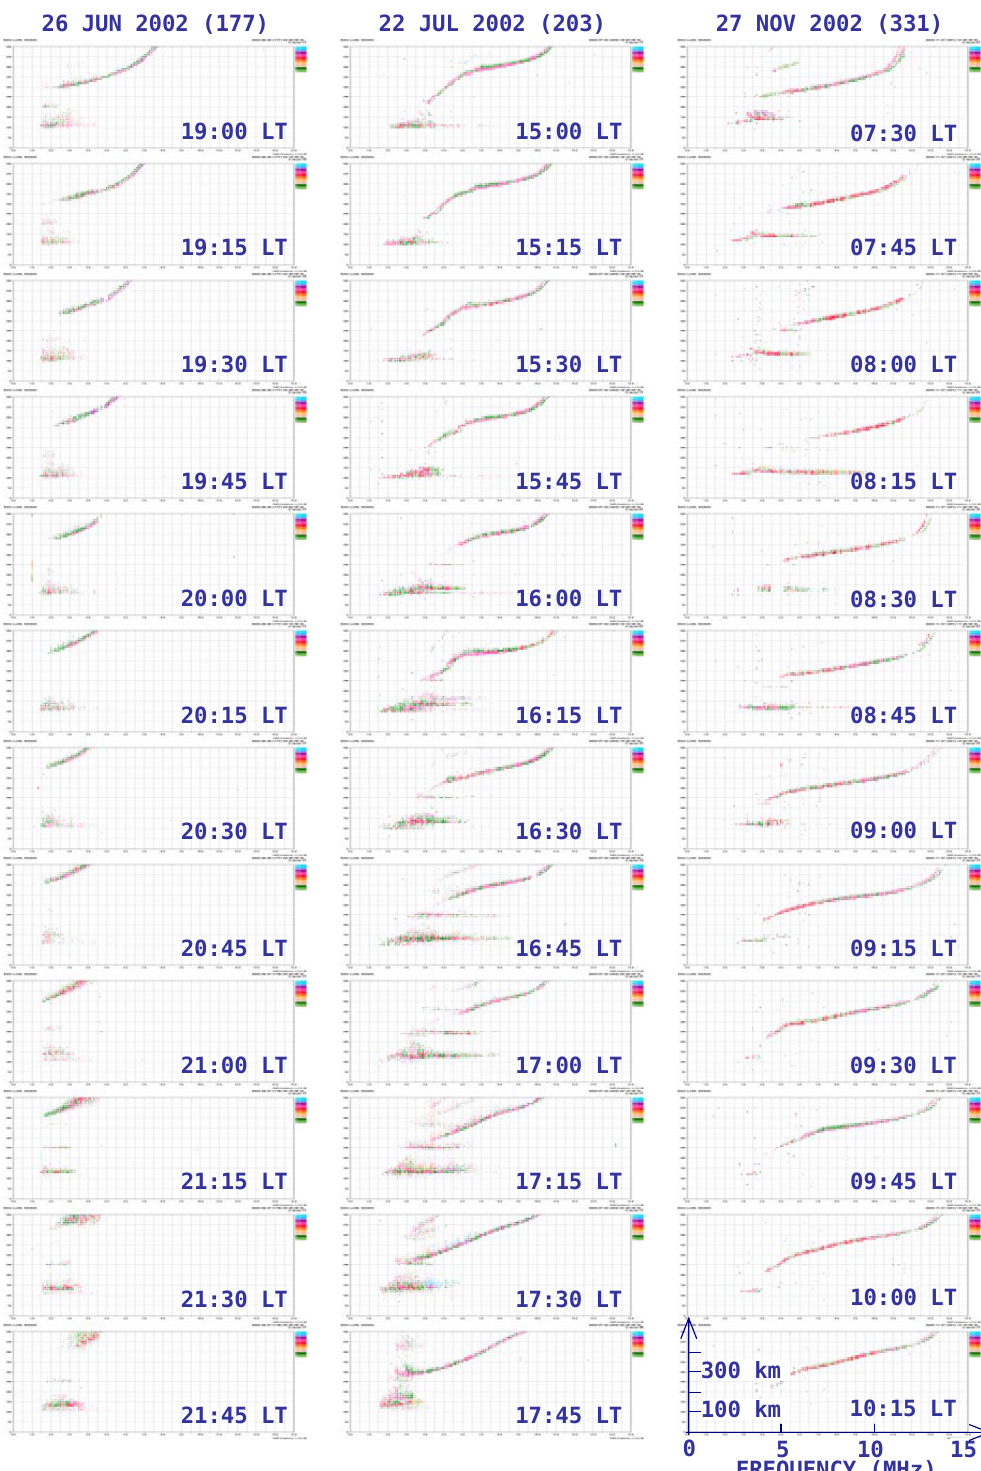
Figure 4. Sequence of ionograms covering the range height from 50 to 500 km, obtained on Fig. 4. Sequence of ionograms covering the height range from 50 to 500km, obtained on 26 June 2002 (left), on 22 July 2002 (middle) and 26 June 2002 (left), on 22 July 2002 (middle) and on 27 November 2002 (right). on 27 November 2002